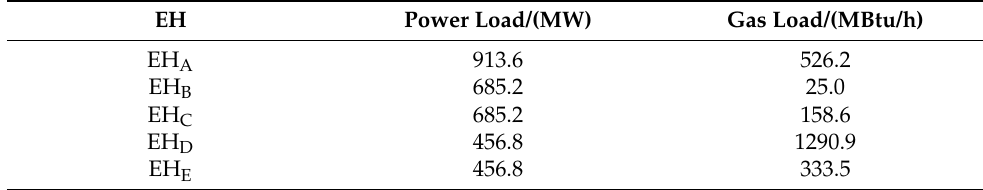
Table 3. Data of the energy